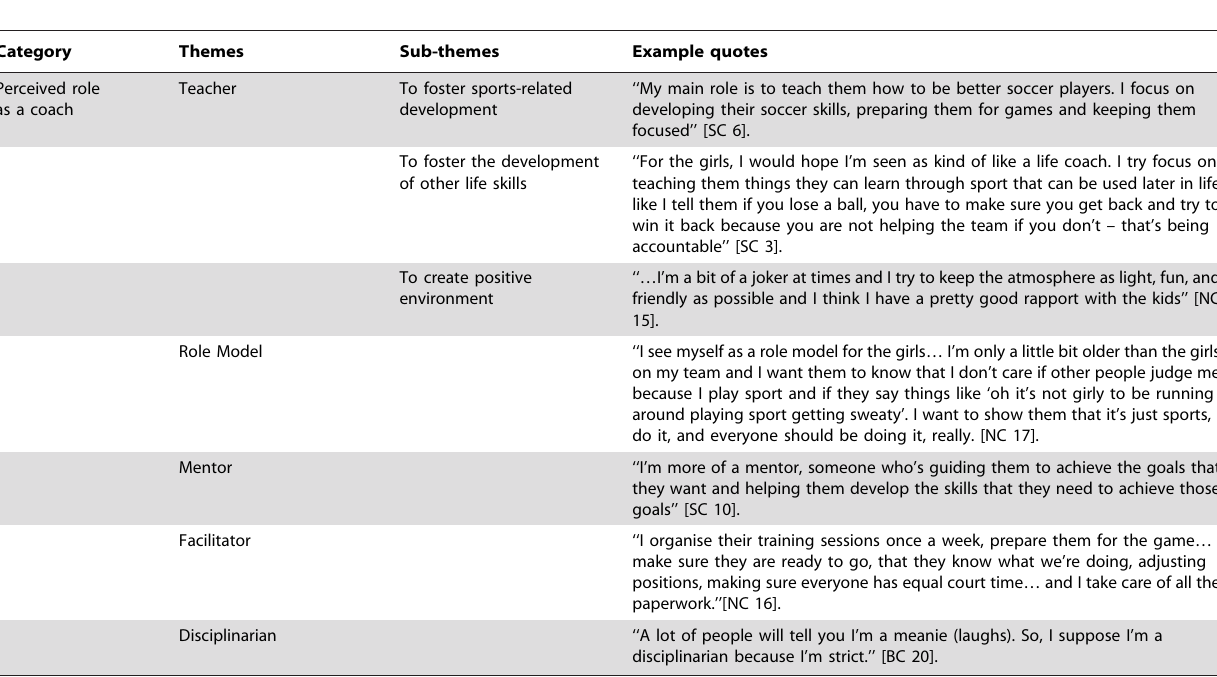
were the most common reasons for coaches not perceiving themselves as role models. Although some coaches did not perceive themselves as particularly good role models for the